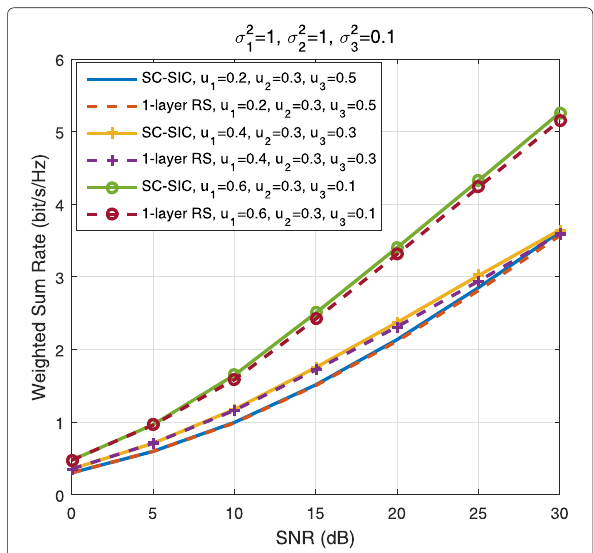
Fig. 45 Weighted sum rate versus SNR comparison of different strategies for overloaded three-user deployment with perfect CSIT, = σ 2 = 1, σ 2 = 0.3, N = 1, r = σ 2 t th 1 2 3